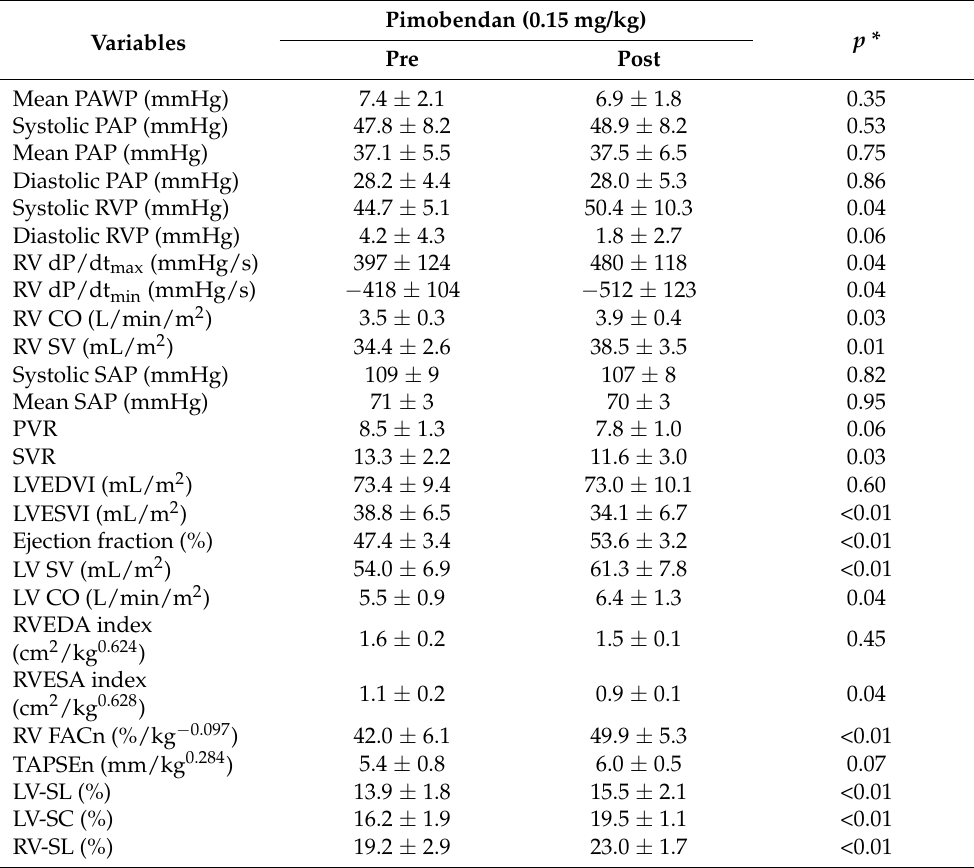
Table 4. Results of hemodynamic and echocardiographic variables before and after pimobendan